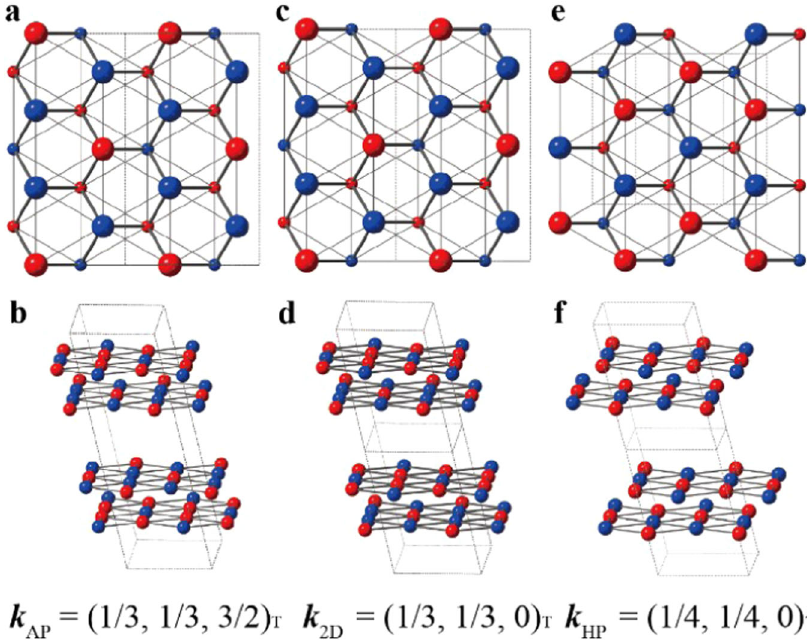
Fig. 2 Charge order models of LuFe 2 O 4 corresponding to observed SXD pattern from 0.8 to 12.6 GPa. Red and blue spheres represent Fe 2 + and Fe 3 + ions, respectively. Sphere size in ( a , c , e ) indicates the Fe ions in different planes. Thick and thin solid lines represent the nearest neighbored (NN) and next-nearest neighbored (NNN) Fe-Fe pairs, respectively. Dashed lines represent lattice boundaries. a , b Centrosymmetric CO-AP model with k ~ (1/3, 1/3, 3/2). c , d Non-centrosymmetric CO-2D model with k ~ (1/3, 1/3, 0) at P = 5.0 GPa. Noted the interlayer arrangements in ( b ) and ( d ) are different due to changes in the L-component of the wave vector. e , f CO-HP model for k = (1/4, 1/4, 0), corresponding SXD patterns observed between 6.0 and 12.6 GPa.